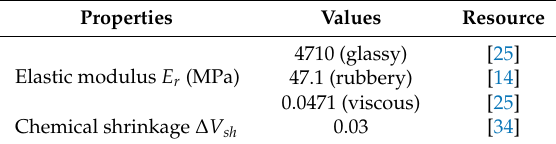
Table 5. Thermoelastic properties of 3900-2 resin.